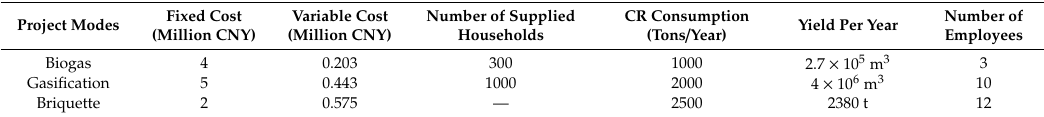
Table 1. Fundamental data of the three types of large-scale crop residue (CR) utilization projects.